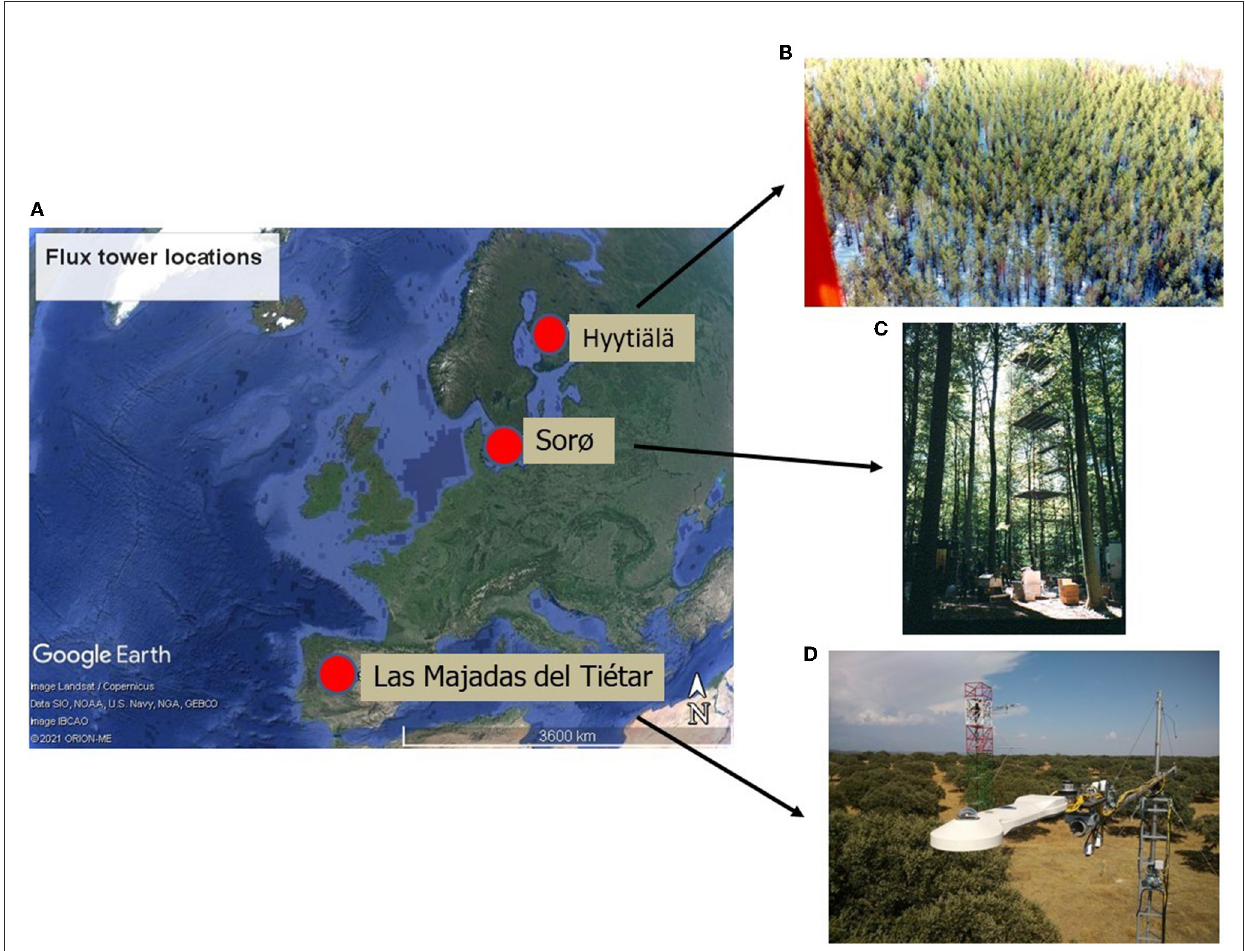
FIGURE1 Location of the three European ecosystems (A) : Evergreen needle leaf forest of Finland (ENF_FI) (B) , Deciduous Broadleaf Forest of Denmark (DBF_DK) (C) and Mediterranean dehesa of Spain (SAV_SP) (D) . Images from CEAM (2021) and Fluxnet (2021). Map in (A) from © Google Earth